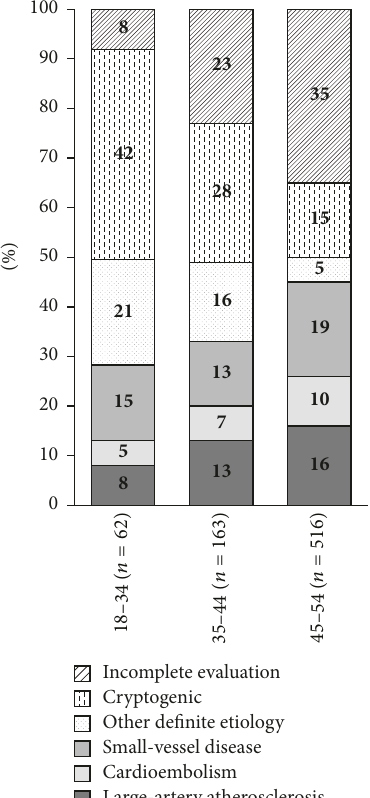
Figure 3: Frequency of etiologic subgroups in age groups of 18–34, 35–44, and 45–54 years. Cryptogenic stroke and incomplete evaluation comprise undetermined etiology according to